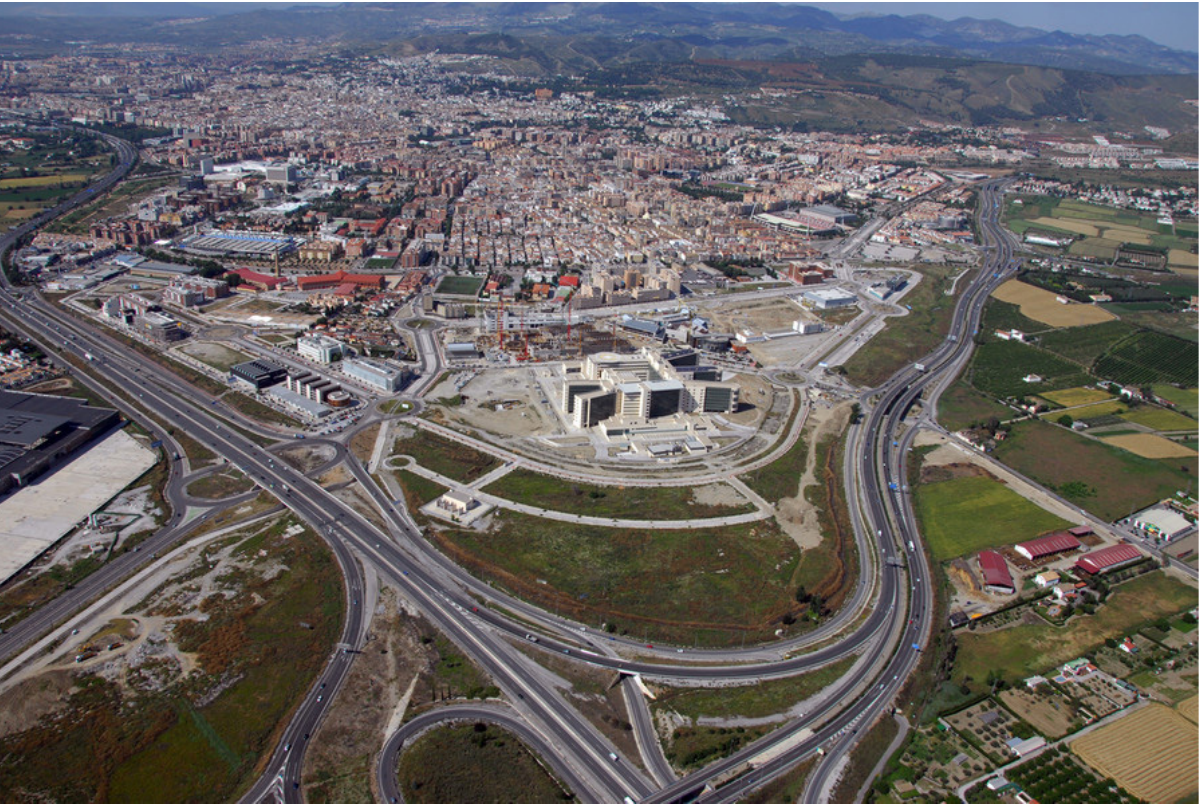
Figure 1: Granada south-east view showing the study area in the foreground, surrounded by the ringway around the city and old part of Granada in the background